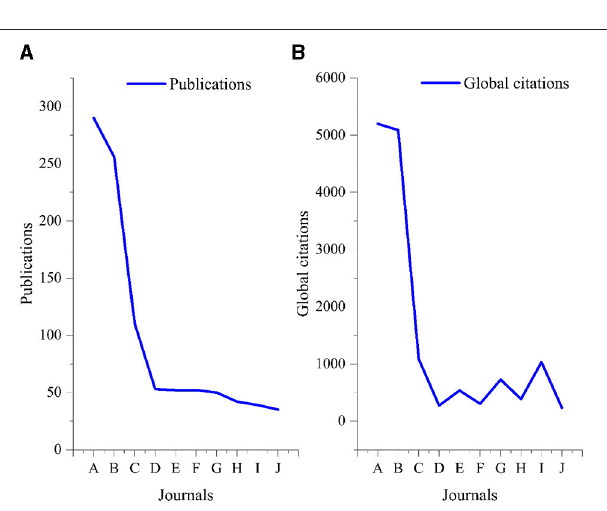
FIGURE 5 | Top 10 most attractive journals in pediatric trauma research (A) Publications (B) Global citations. The Journal of Trauma and Acute Care Surgery ( n = 124), previously known as The Journal of Trauma-Injury Infection and Critical Care ( n = 166), after adding both values the Journal of Trauma and Acute Care Surgery. (https://journals.lww.com/jtrauma/pages/ aboutthejournal.aspx) was ranked 1st ( n = 290). A: The Journal of Trauma and